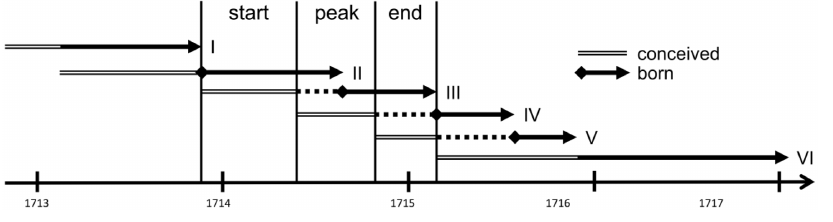
Figure 3. Time line illustrates the chronology of the six exposure statuses during conception.